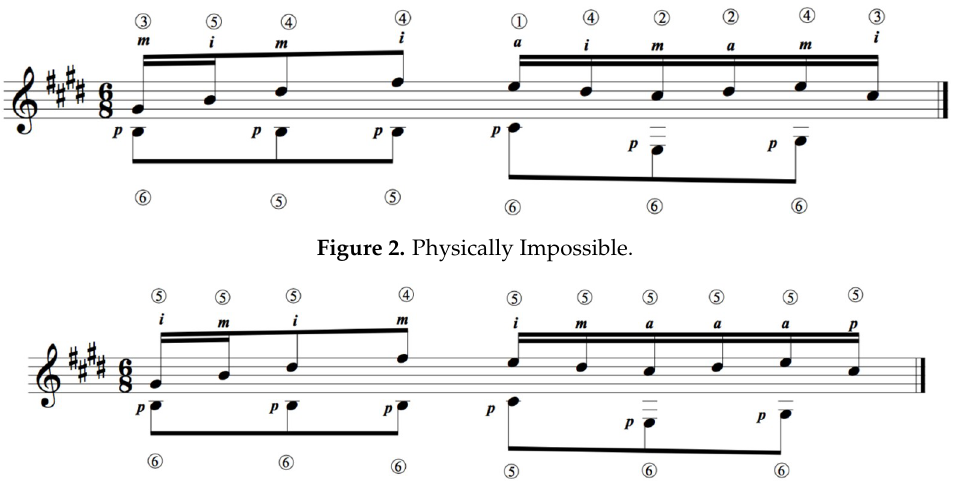
Figure 3. Physically Impossible.